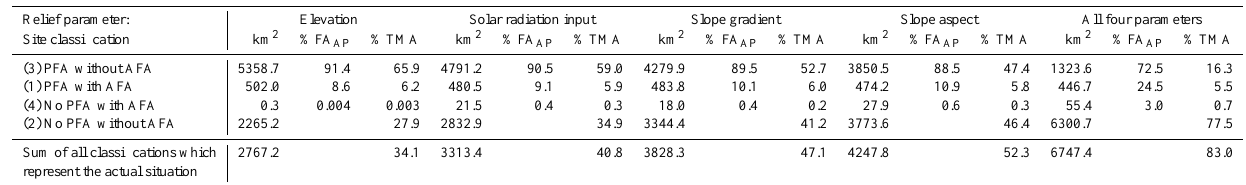
Figure 10. Distribution of AFA and the 5 ◦ C monthly isotherms during the growing season Table 3. Comparison between of the modeled area values of single relief parameter classes and of the combination of all four relief parame- ters. (AFA: actual forest area; PFA: potential forest